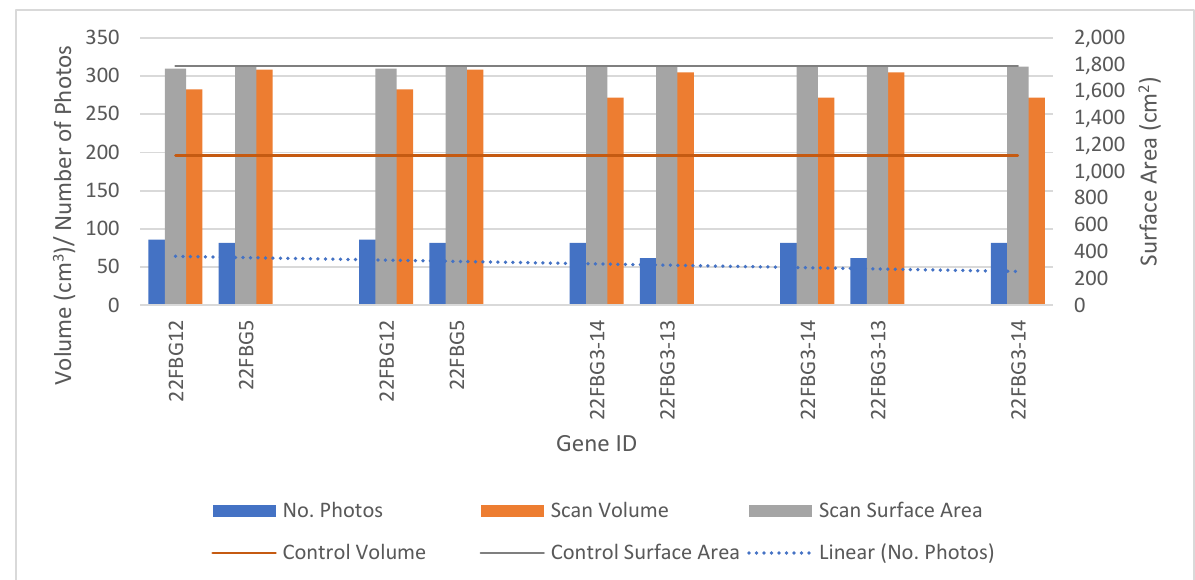
8 of 16 Figure 3. A digitised and imported socket in Autodesk Fusion 360: ( a ) socket scan 22FBG7-1 segmented around central axis, showing alternate segments; ( b ) vertical cut lines on with both sockets aligned and visible with the white model being the scan and orange being the control model; ( c ) sample slice with top surface highlighted; ( d ) sample slice with loop length highlighted; ( e ) sample slice with perpendicular wall thickness of single segment. 3. Results The final selected experiment photo set referred to as “22FBG3 - 14” was identified during the third generation and achieved the highest fitness score throughout the remain- ing generations. Gene set 22FBG3-14 was comprised of 82 photos and had an accuracy in terms of socket wall volume, surface area and height of 61.63%, 99.61% and 99.90%, re-